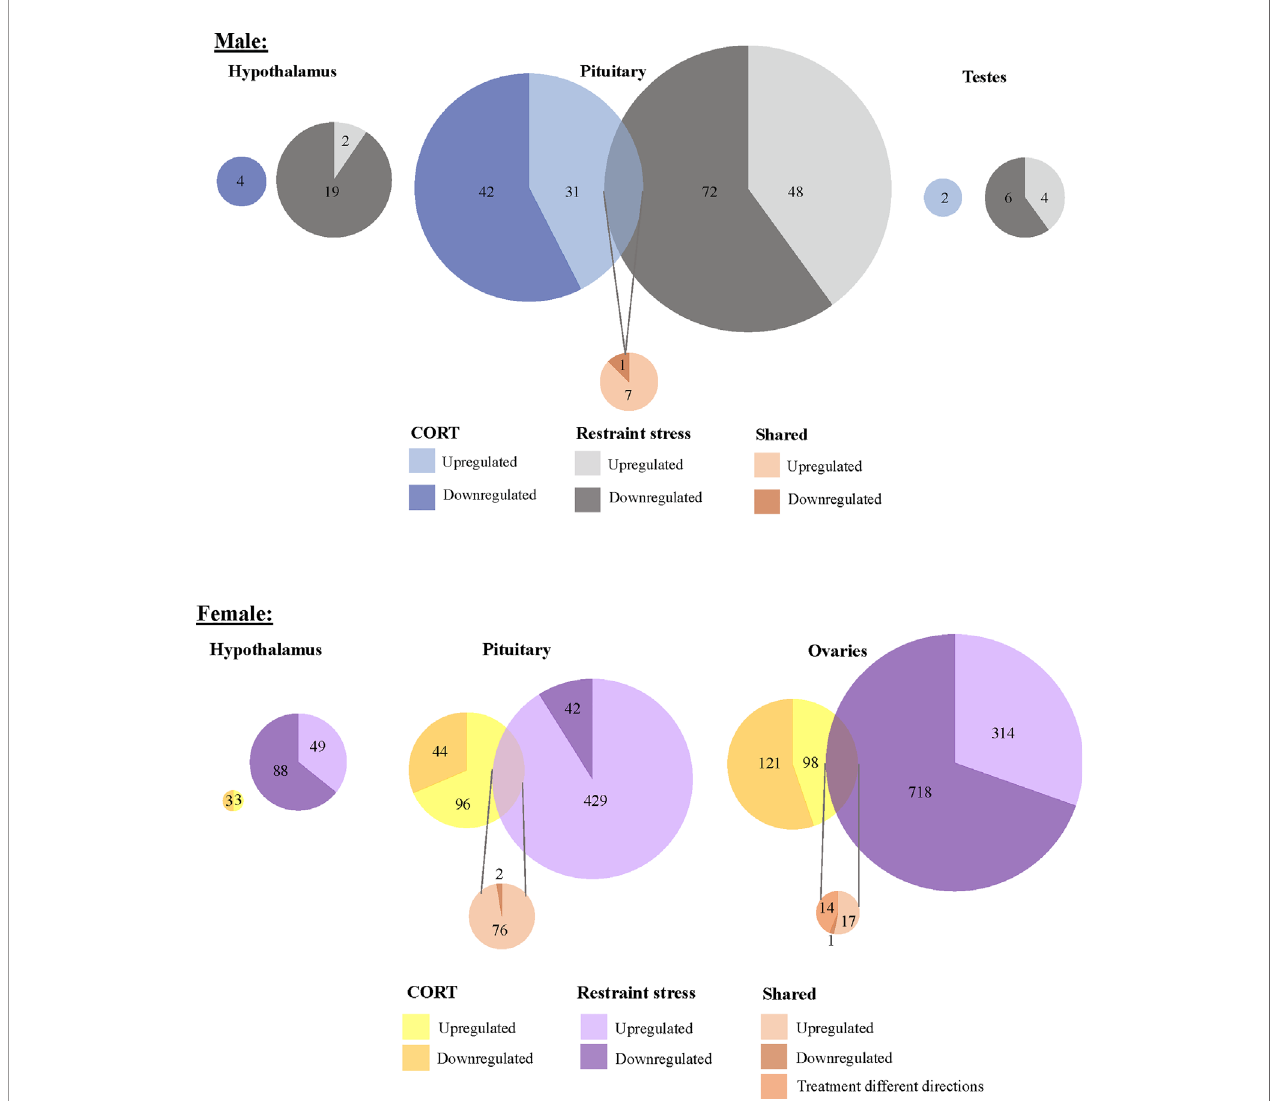
FIGURE 5 | Shared and unique gene expression responses to CORT treatment and restraint-stress. Weighted Venn diagrams of signi fi cantly differentially expressed genes for male (top) and female (bottom) of CORT-treated and restraint stress treatments (data from Calisi et al. (10) in the hypothalamus, pituitary and gonads. Circles are proportional within males and females, but not